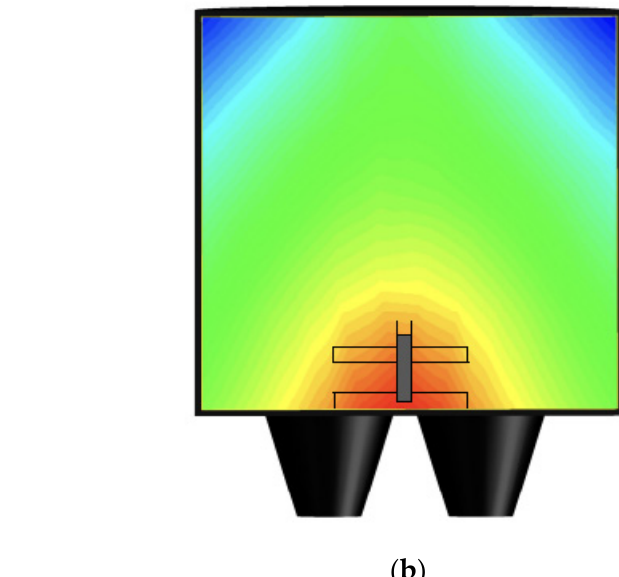
Figure 11. Self-made ultrasonic generator. ( a ) Top view ( b ) Main view